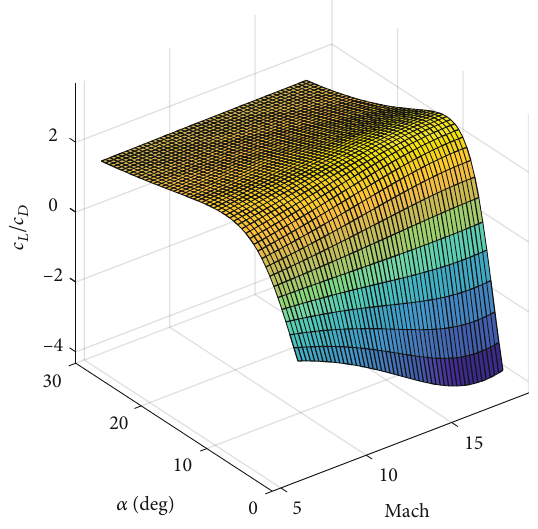
Figure 3: Lift-to drag ratio with respect to the Mach number and angle of attack.